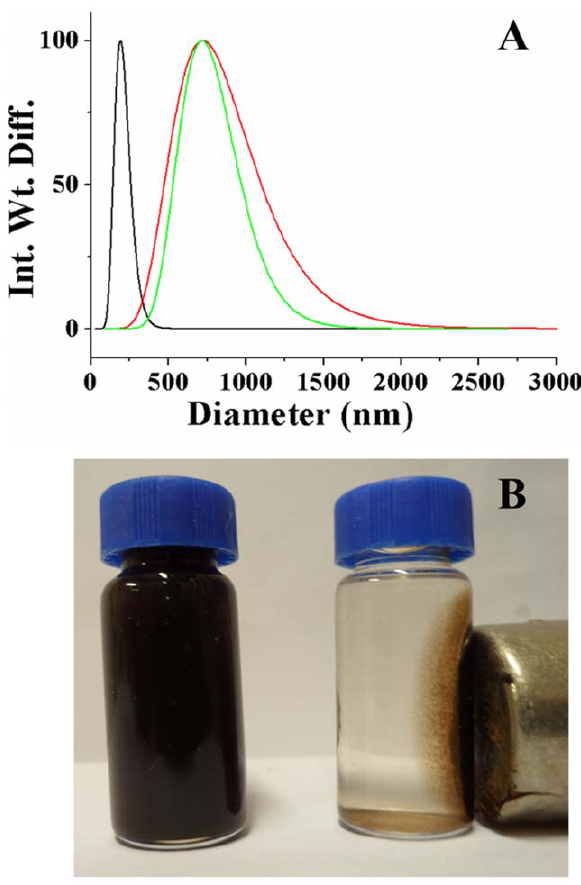
Figure 5. Particle size distributions and magnetic property of the composites. Particle size distributions of IONPs (black), CS-IONPs (red) and CCS-IONPs (green) in ultrapure water (A). Particle sizes were determined by dynamic light scattering, the composites were dispersed at a concentration of 0.1 mg/ml in ultrapure water with ultrasonication for 15 minutes. Dispersion and magnetic property of the CCS-IONPs composites (B). Photographs of an aqueous suspension of the CCS- IONPs composites before (left) and after (right) magnetic isolation.